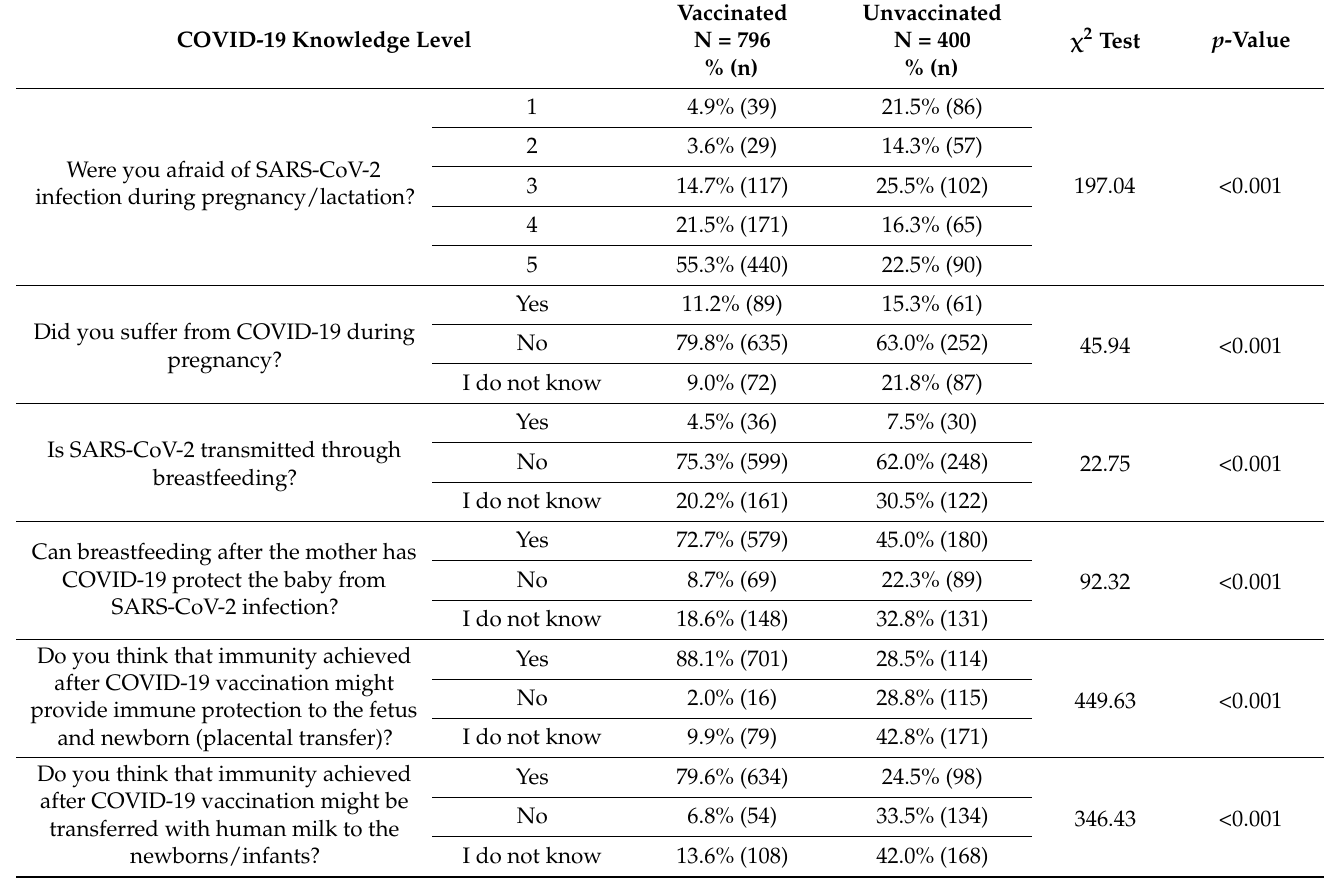
Table 4. Level of COVID-19 knowledge in relation to COVID-19 vaccination among